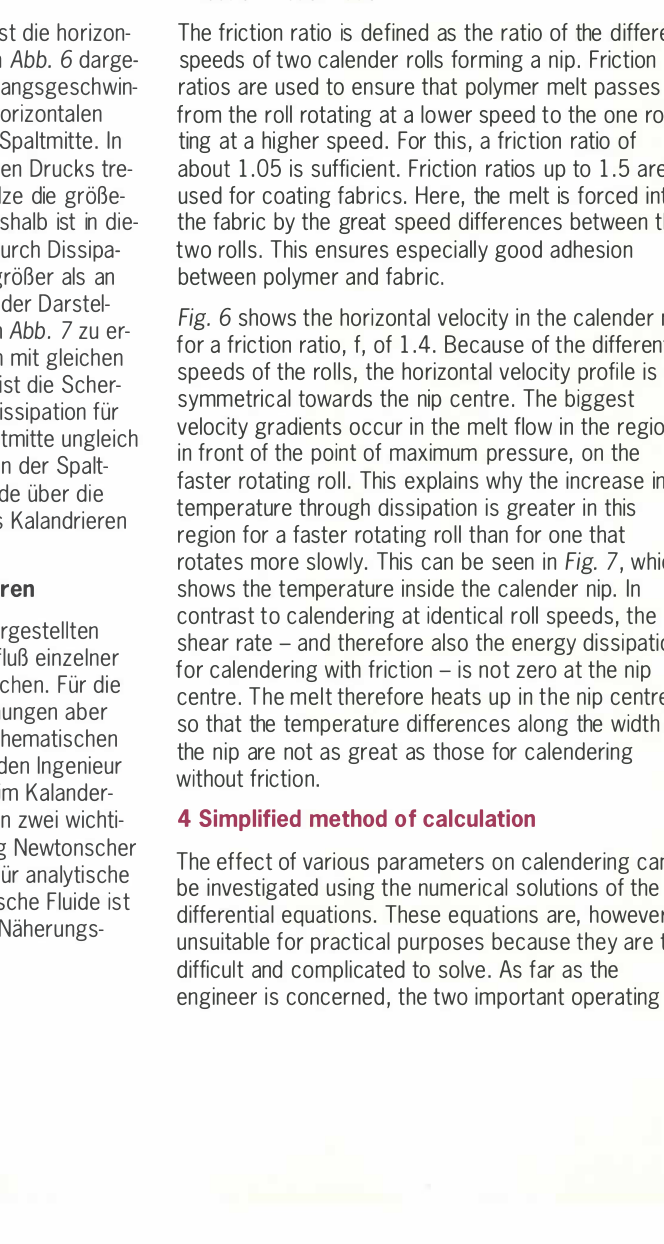
Effect of friction ratio